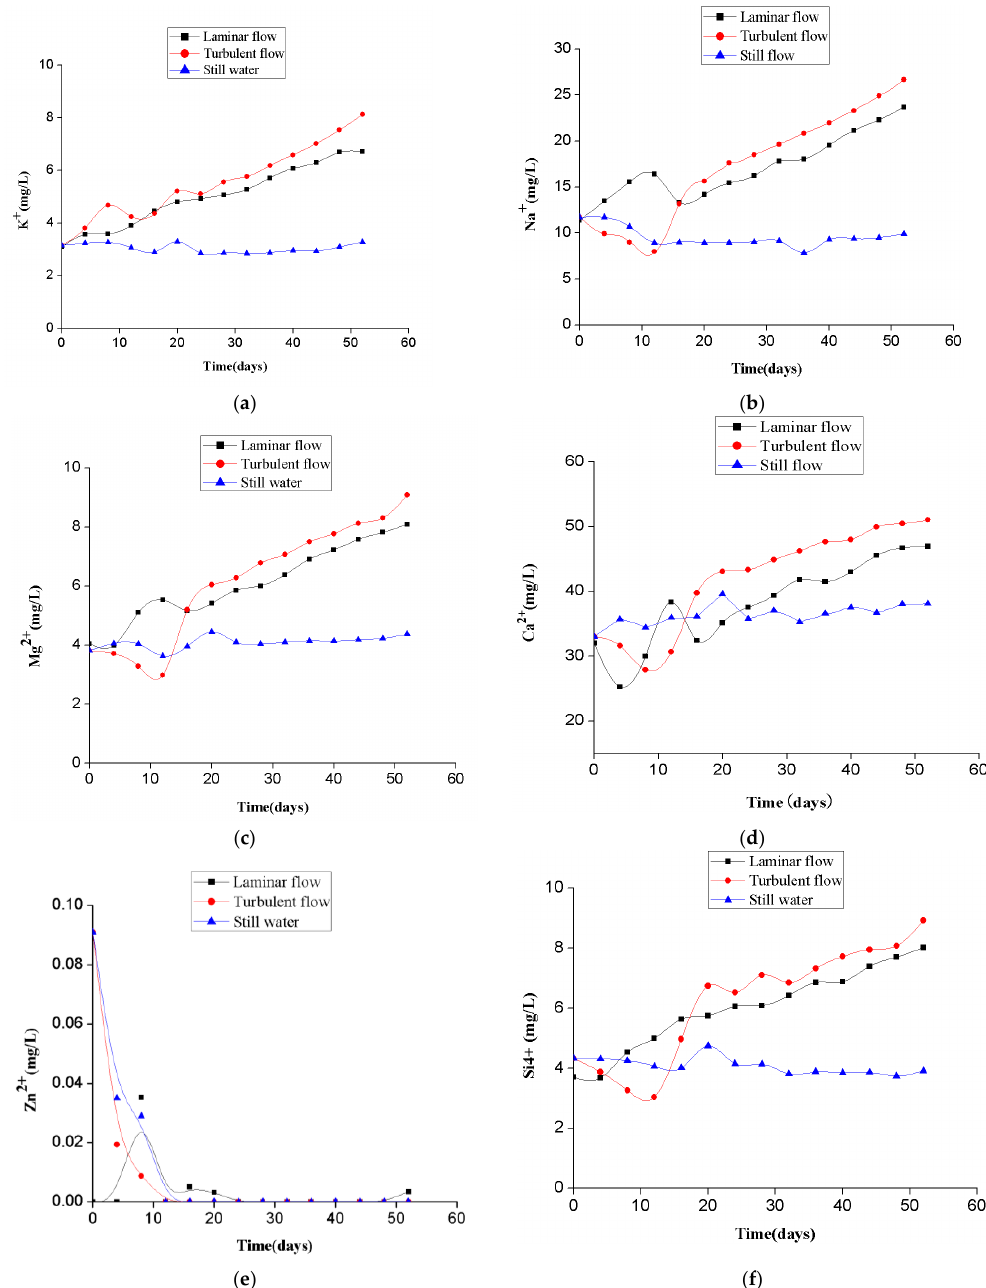
Figure 7. Concentration curves of major cations in circulating aqueous solution under different flow patterns ( a ) Concentration variation of K+; ( b ) Concentration variation of Na + ; ( c ) Concentration patterns ( a ) Concentration variation of K + ; ( b ) Concentration variation of Na + ; ( c ) Concentration variation of Mg 2+ ; ( d ) Concentration variation of Ca 2+ ; ( e ) Concentration variation of Zn 4+ ; ( f ) variation of Mg 2 + ; ( d ) Concentration variation of Ca 2 + ; ( e ) Concentration variation of Zn 4 + ; Concentration variation of Si 4+ . ( f ) Concentration variation of Si 4 +